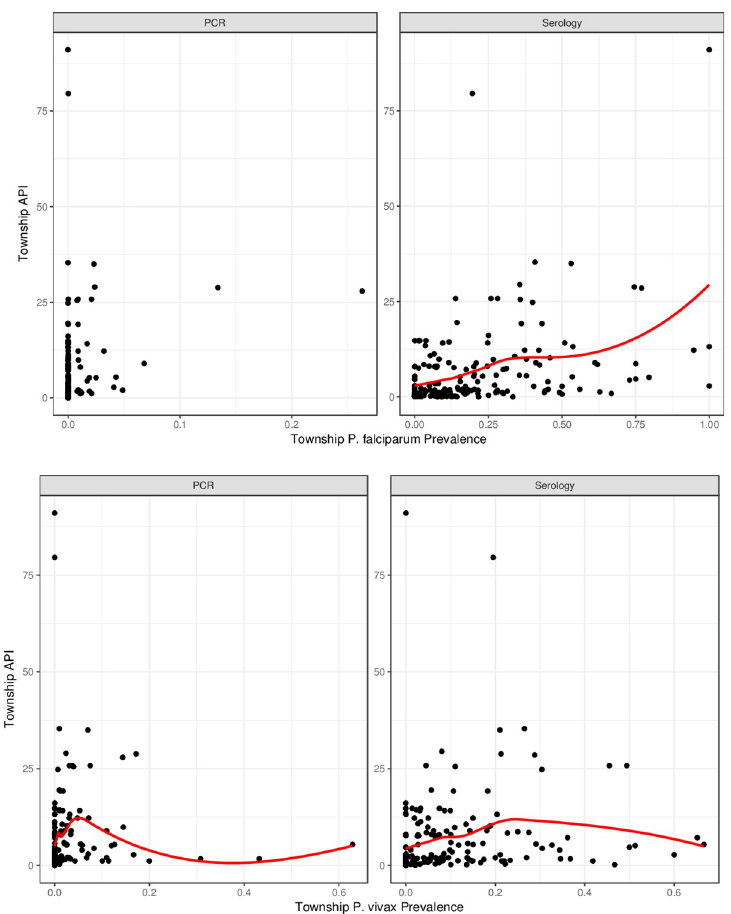
Fig 6. Association of prevalence and seroprevalence with incidence data, aggregated by township and split by P . falciparum (top) and P . vivax